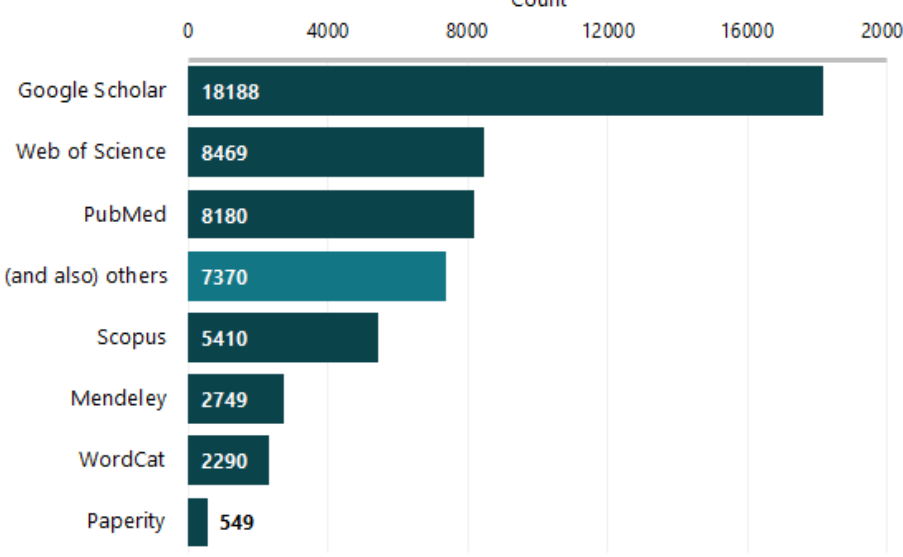
Figure 3: Fragment from the survey results demonstrating the usage of digital tools for data search (source: https://101innovations.wordpress.com/survey-results/research-activities/search/).